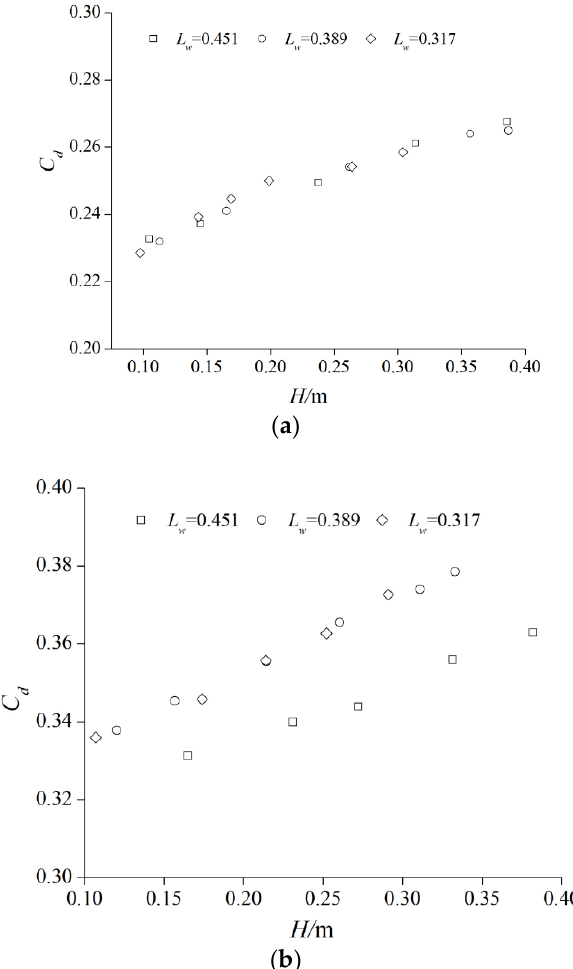
Figure 8. Discharge coefficient ( C d ) versus weir head ( H ) together with different weir lengths ( L w ): ( a ) with FGP ( β = 0.51, θ = 15°); ( b ) without FGP.